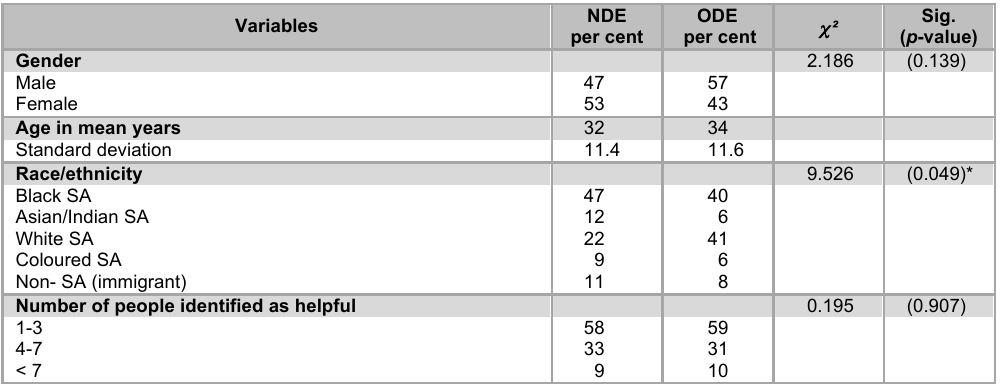
Sample statistics with differences between NDE (n = 102) vs. ODE (n = 101)